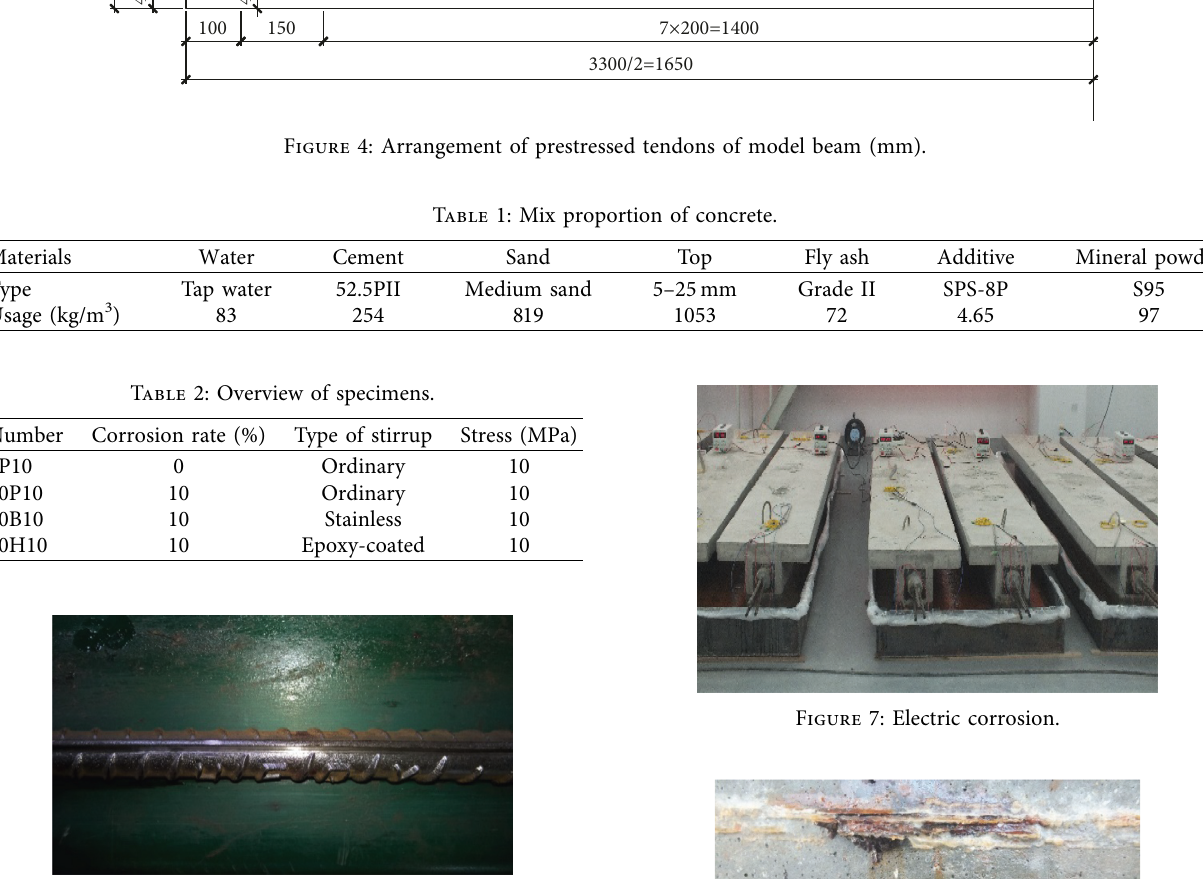
Figure 5: A groove of longitudinal reinforcement.